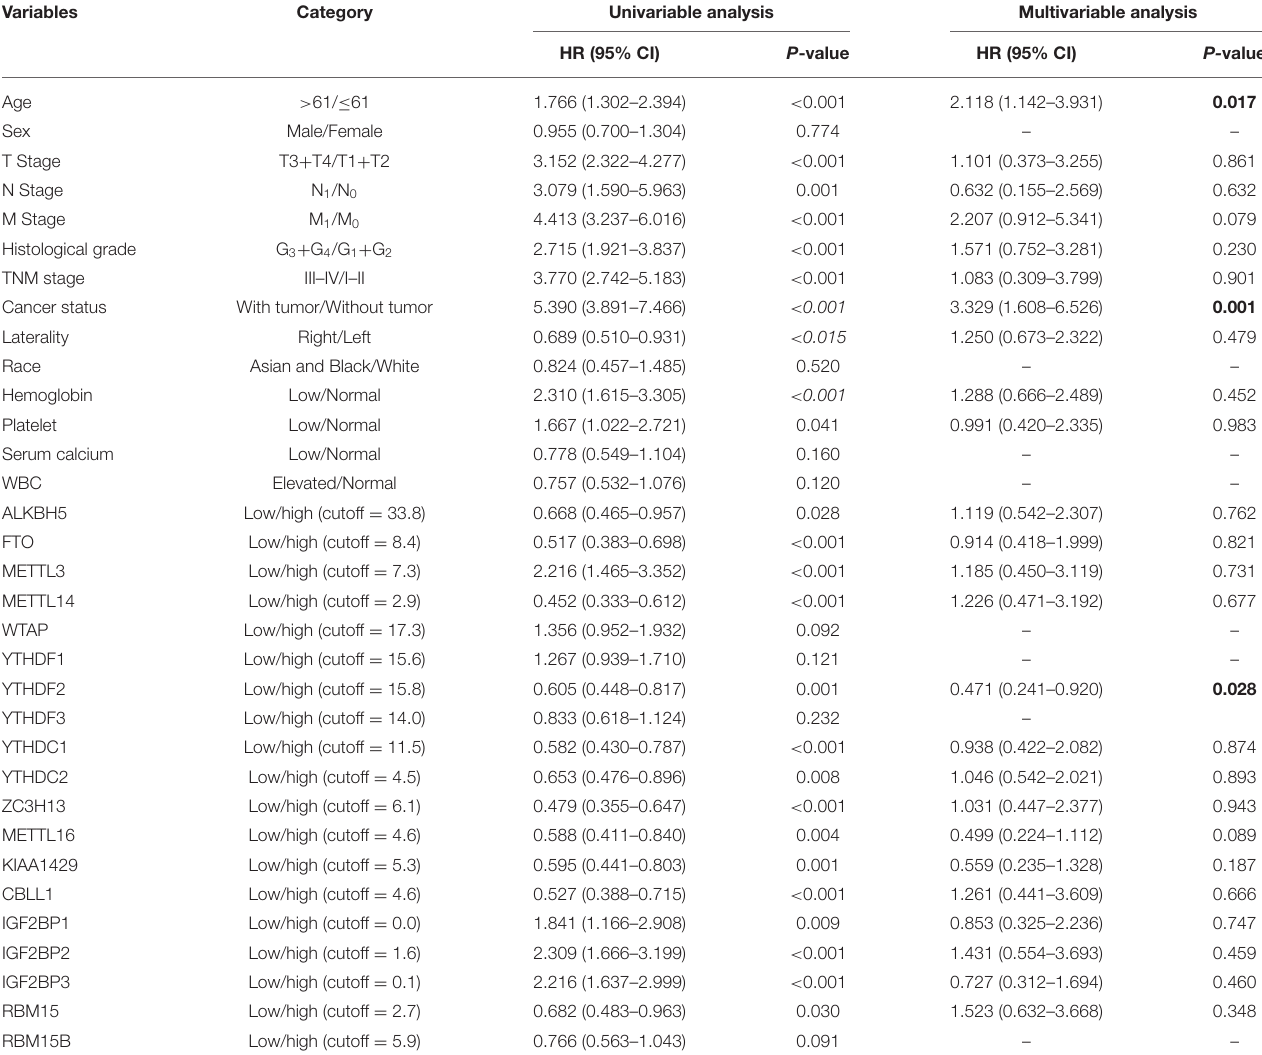
TABLE 2 | Univariate and multivariate analysis of overall survival using the Cox proportional hazards regression model.